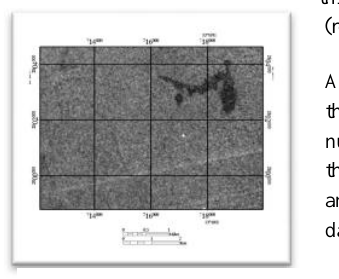
Figure 10: comparison of